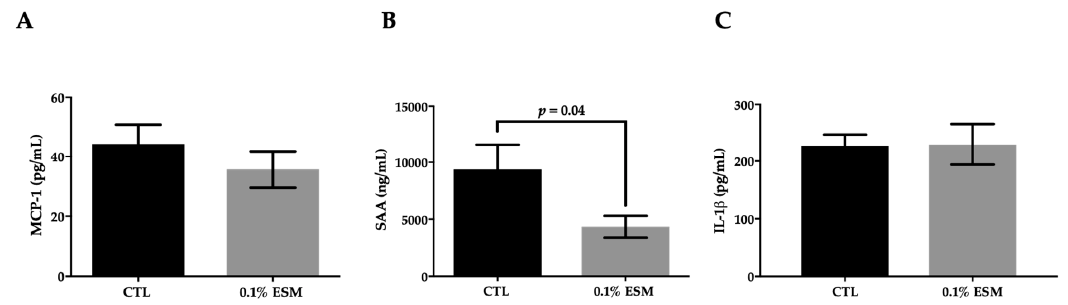
Figure 1. Effect of ESM on circulatory markers of inflammation. Measures of serum monocyte chemoattractant protein 1 (MCP-1) ( A ), serum amyloid A (SAA) ( B ), and interleukin (IL)-1 β ( C ) after eight weeks on a high-fat diet (HFD) with or without ESM. Values are reported as mean ± SEM ( n = 15 per group). CTL = control; ESM = egg sphingomyelin; IL-1 β = interleukin-1-beta; MCP-1 = monocyte chemoattractant protein-1; SAA = serum amyloid A.